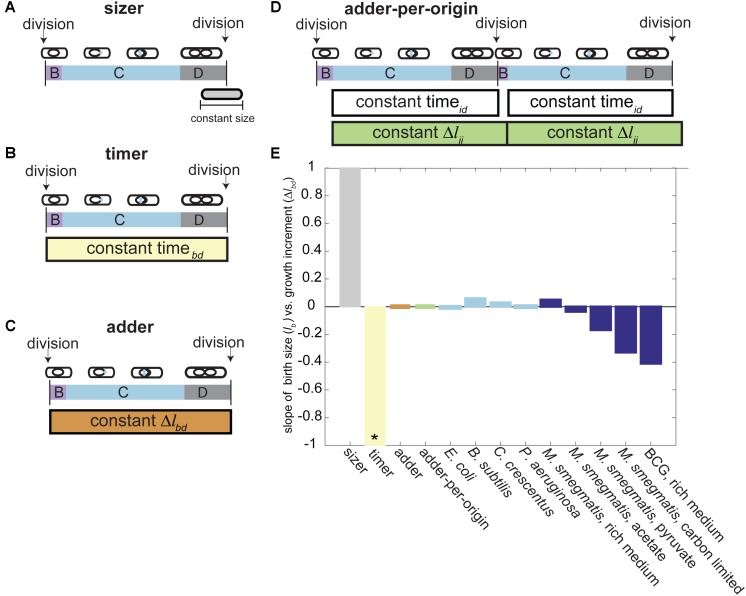
Models of bacterial cell size control. (A) In the sizer model, cells divide once they reach a constant size (e.g., cells divide once reaching 7 μm in length). (B) In the timer model, cells divide a constant time after birth (e.g., cells divide 100 min after birth). (C) In the adder model, cells divide after adding a constant growth increment from birth (e.g., cells divide after adding 3 μm to their birth length). (D) In the adder-per-origin model, cells add a constant increment from initiation to initiation and then divide a constant time after initiation (e.g., cells divide 100 min after initiation, and grow 3 μm between initiation events). (E) Bar plot depicting the slope of cell birth length (Δlb) versus birth to division adder increment (Δlbd) for several size control models and bacterial populations. Model predictions for the slope of Δlb vs. Δlbd are shown on the left of the graph. The sizer model (left, gray bar) predicts a slope of 1, because cells born smaller must grow more to reach the required size for division (Koch and Schaechter, 1962; Sauls et al., 2016). The timer model (yellow bar) predicts a slope of –1. In a population of cells where growth rate is exponentially correlated with cell size, larger cells are expected to grow more than smaller cells in the same amount of time, giving a negative slope (Robert et al., 2014; Sauls et al., 2016; Willis and Huang, 2017). The adder model supposes that all cells add a constant growth increment from birth to division regardless of birth size and thus gives a slope of 0 (Taheri-Araghi et al., 2015a). The adder-per-origin model posits that all cells grow a constant length from initiation to initiation, and then divide a constant time after initiation. However, a constant adder from initiation to initiation mathematically reduces to an adder correlation from birth to division, giving a slope of zero (Amir, 2014). Light blue bars represent lb vs. Δlbd slope measurements from populations of model bacteria. E. coli and B. subtilis from Taheri-Araghi et al. (2015a), C. crescentus from Campos et al. (2014), P. aeruginosa from Deforet et al. (2015). Dark blue bars represent lb vs. Δlbd slope measurements from mycobacterial populations. M. smegmatis rich media, carbon limited, and BCG from Logsdon et al. (2017). M. smegmatis acetate and pyruvate from Priestman et al. (2017). ∗The timer model was shown in several studies to be incompatible with generation of stable bacterial cell size homeostasis (Trucco and Bell, 1970; Robert et al., 2014).